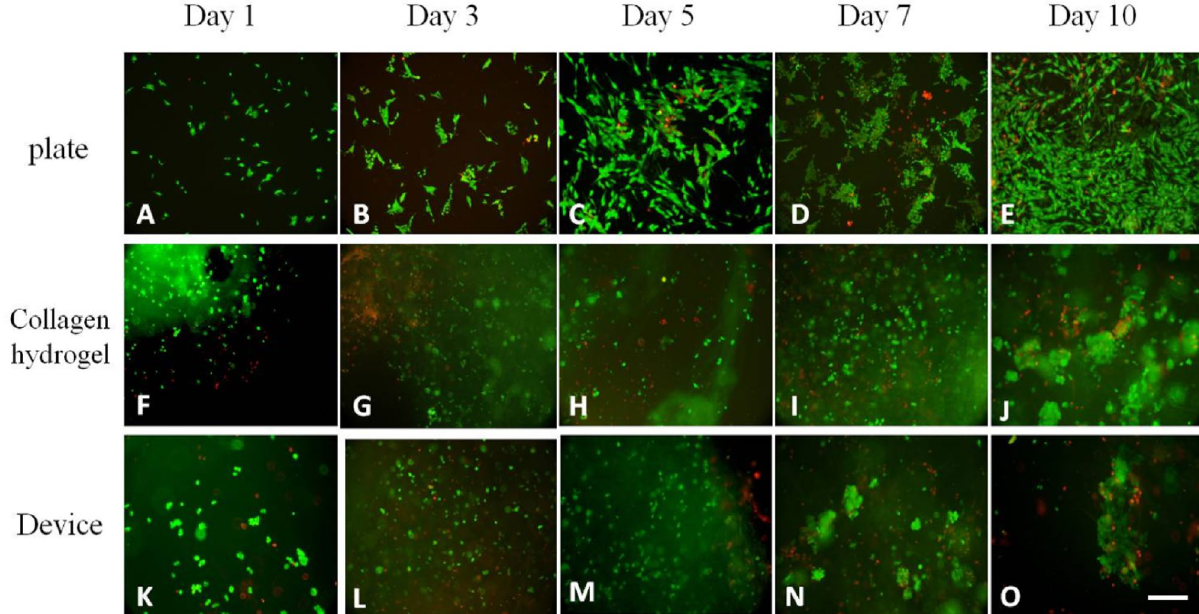
Figure 6. Live/dead assay of Cri-D2 cells encapsulated in collagen hydrogel, within the device and cultured in a 12-well plate. Cells have diffuse distribution and many green-stained cells are seen at the core of the hydrogel and device ( F – O ). Cluster formation ( I , J , N , and O ). The number of cells in plates ( A , B , C , and D ) are near to the cells in collagen hydrogel and the device; while many cells cultured in the plate died on the 10th day due to a lack of space to grow ( E ). (Scale bar: 200